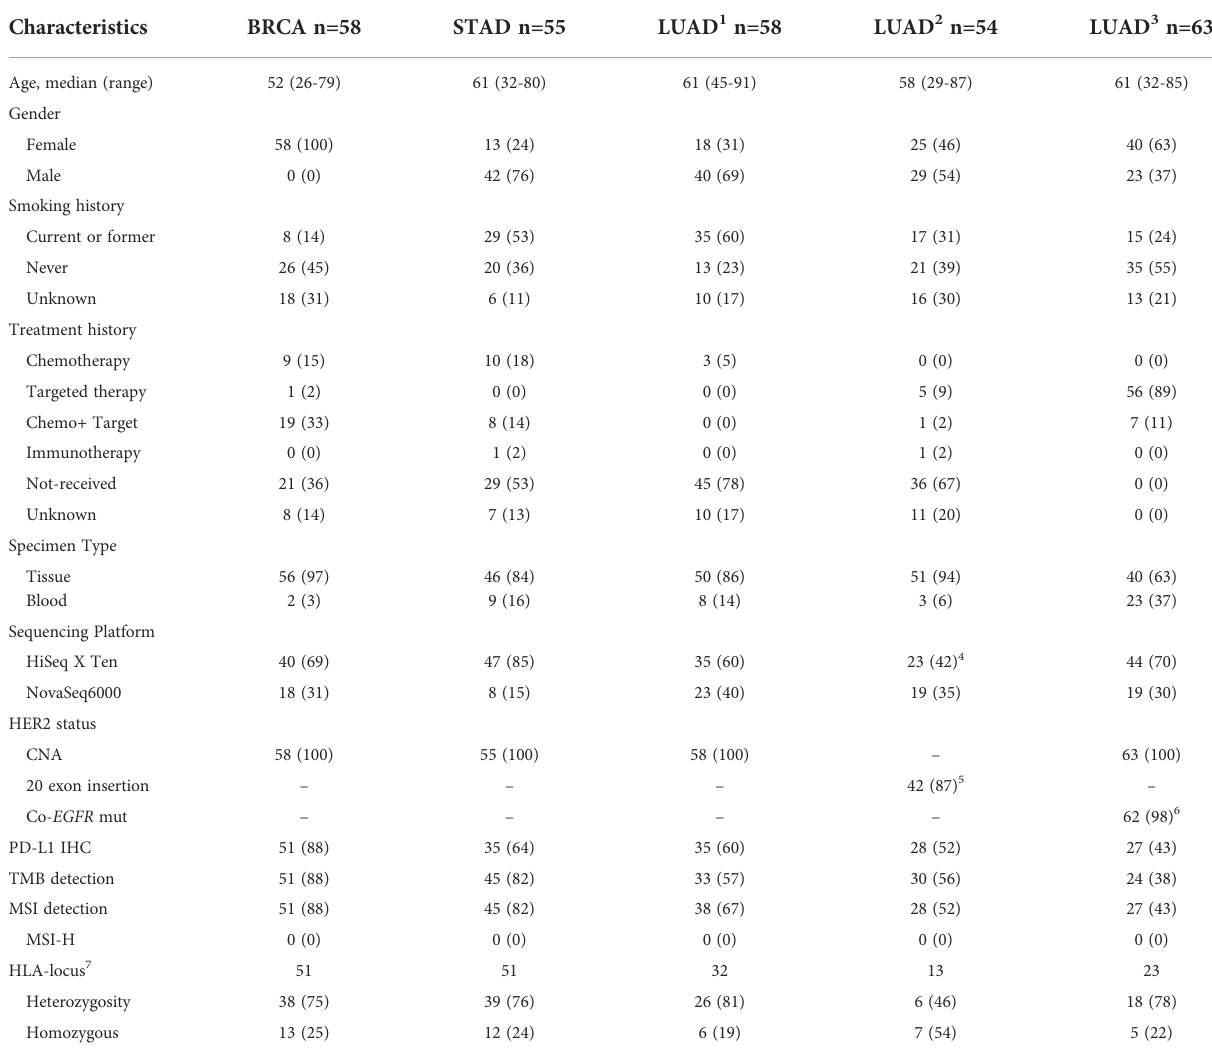
TABLE 1 Characteristics of patients in the validation